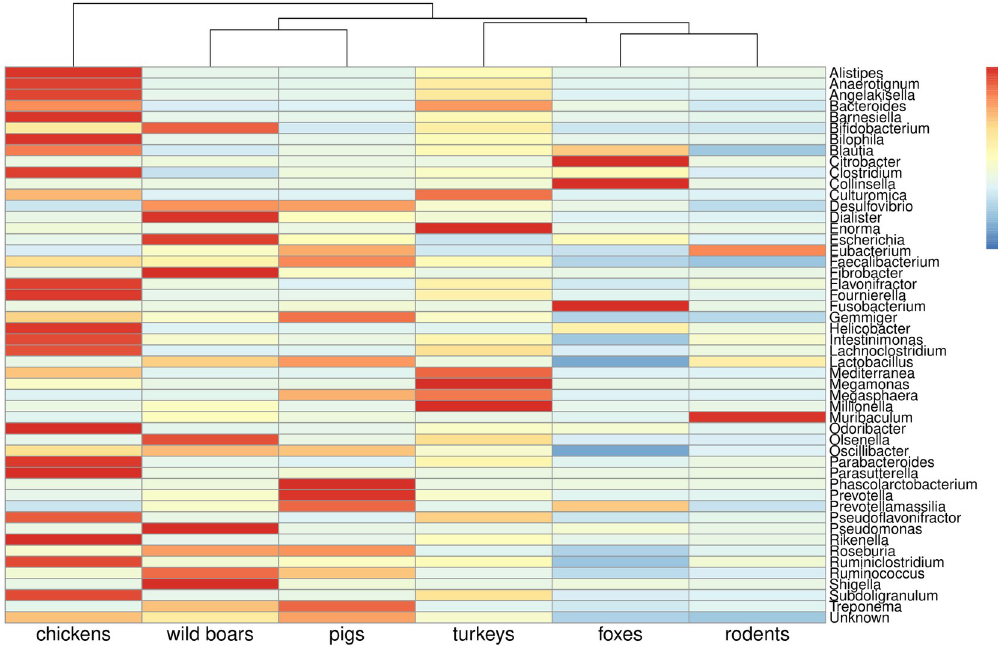
Fig 6. Bacterial composition at genera level by animal source. Heat map presents the 50 most abundant bacterial genera based on relative abundances values with Z-score scaling. Samples with high relative abundances get positive values (red color) and those with relatively low get negative values (blue colors). Complete-linkage clustering of Euclidian distances was applied for clustering the samples.